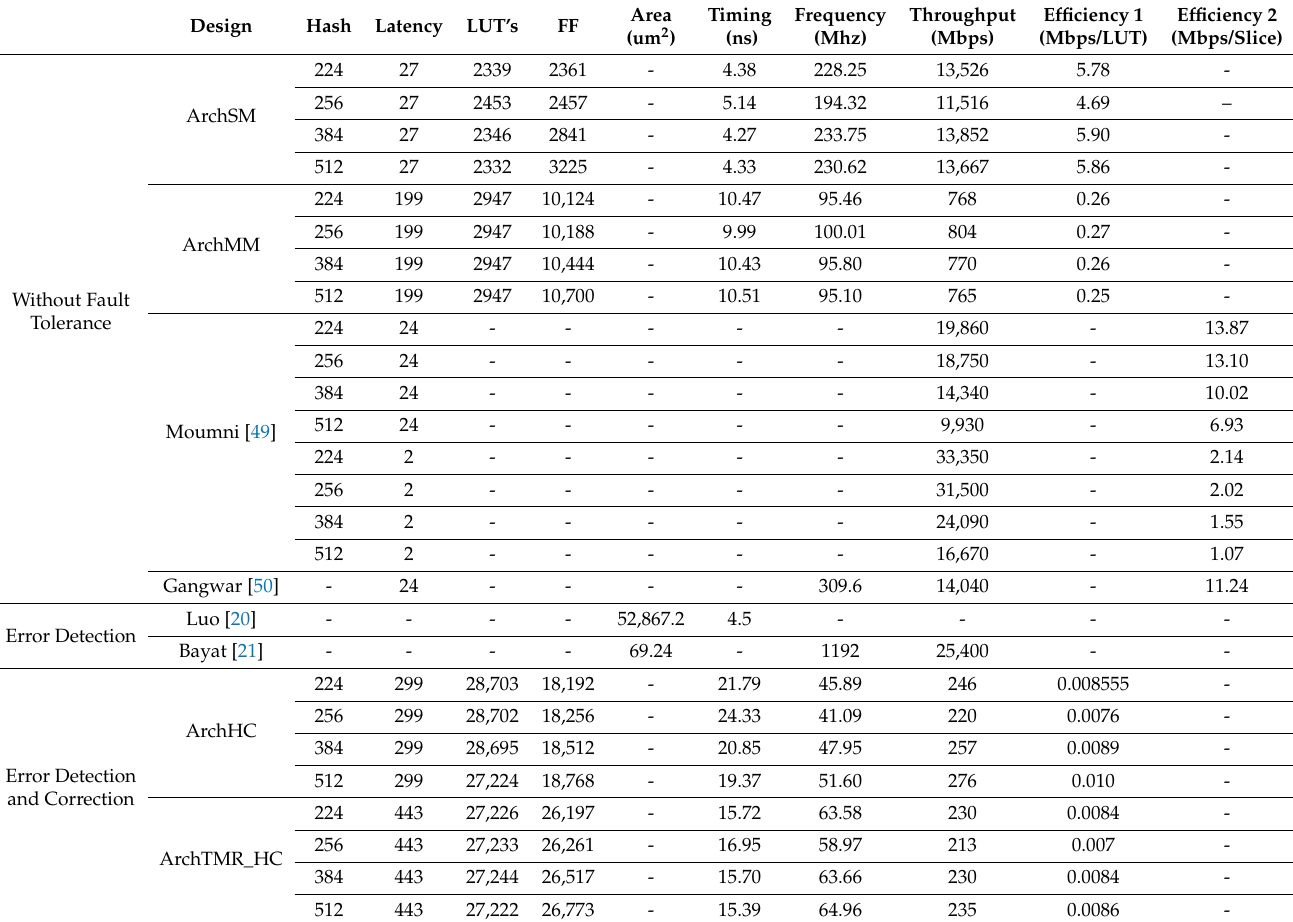
Table 7. Results comparison among different